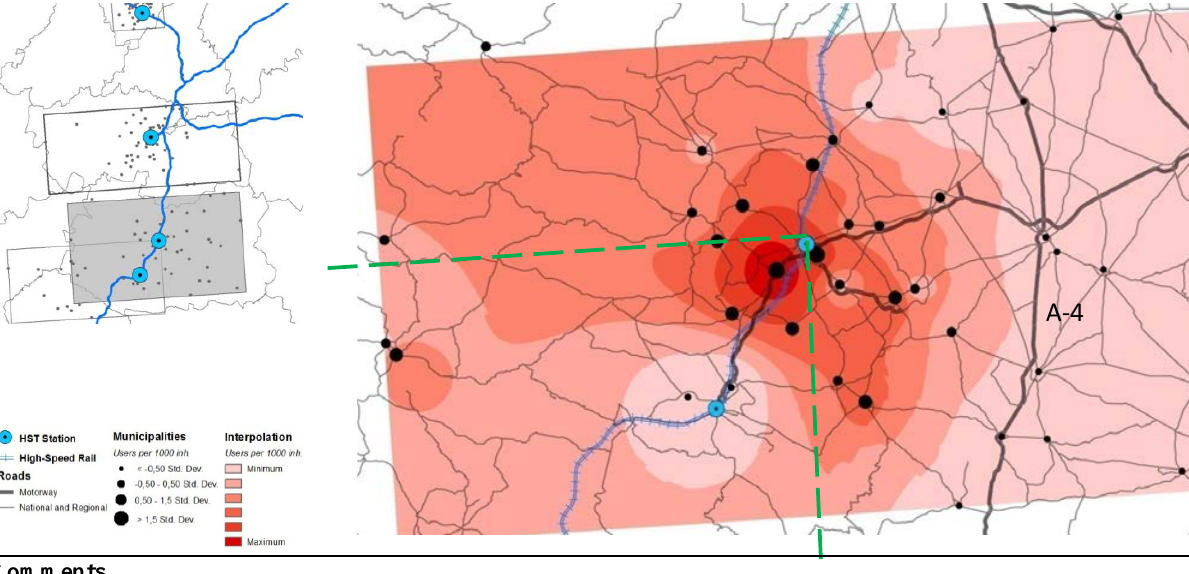
Figure 9. Ciudad Real’s catchment area